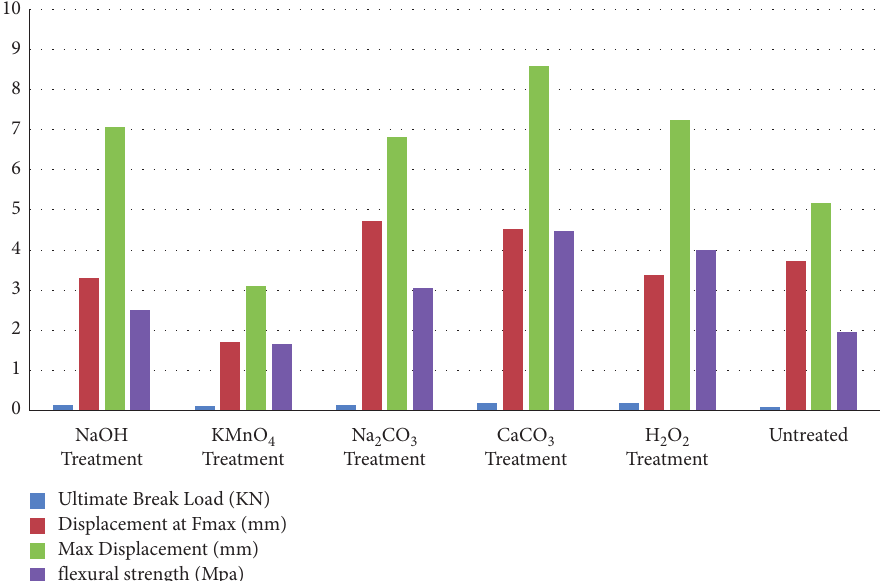
Figure 3: Ultimate flexural strength vs. treated and untreated fibers with